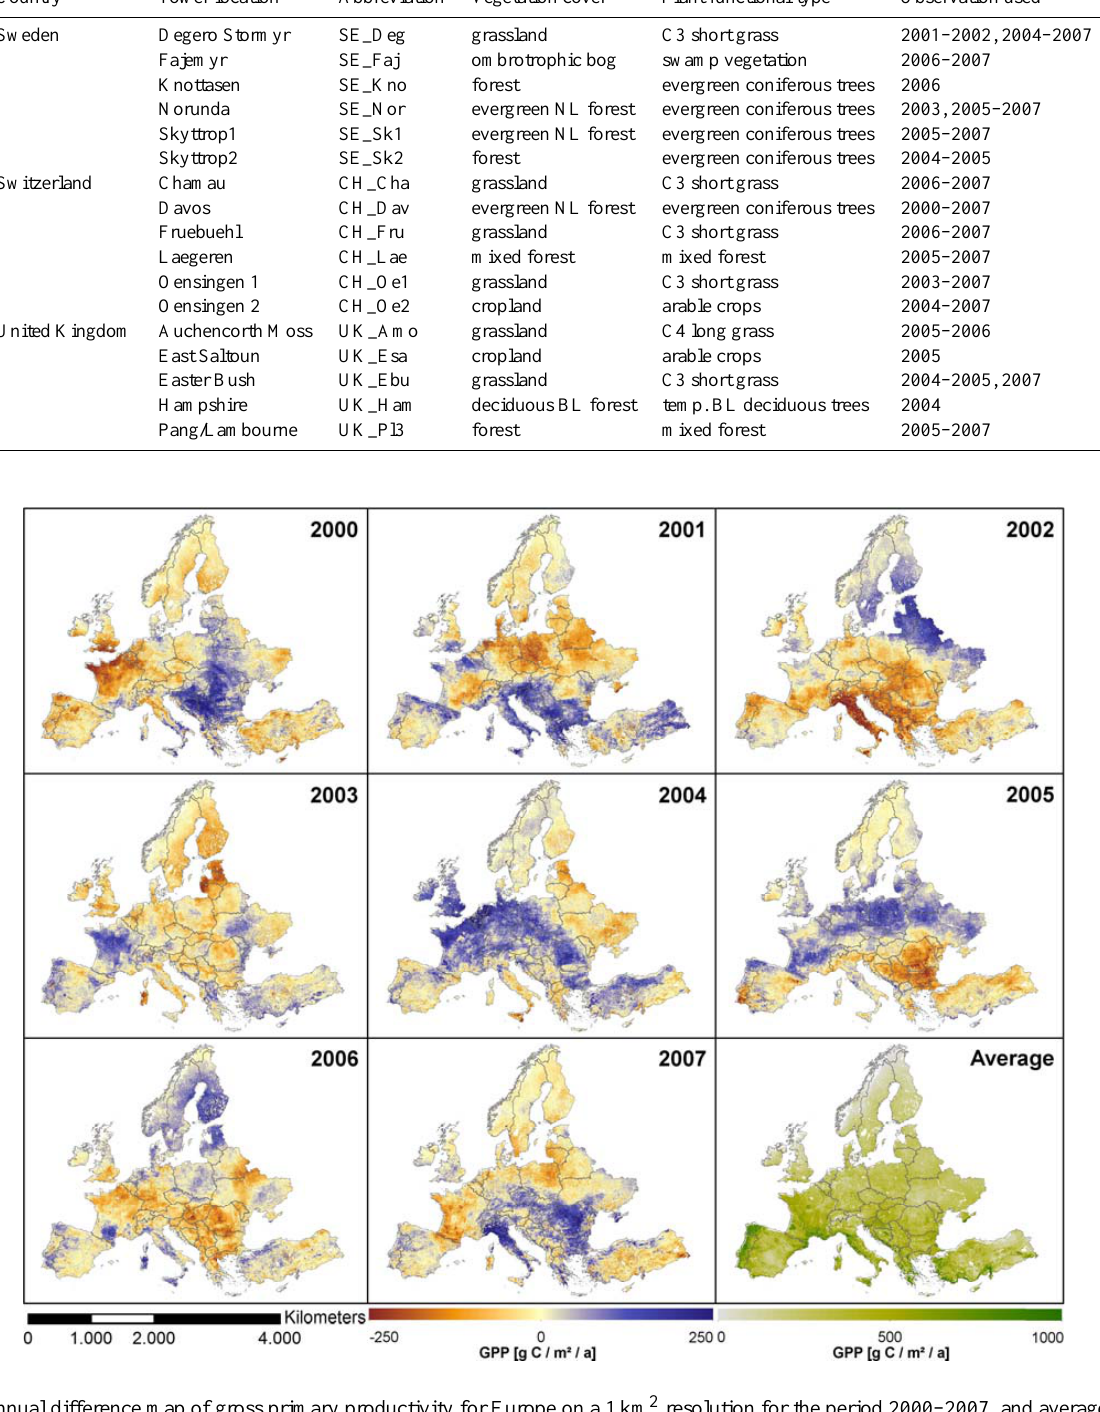
Figure 2: Annual difference map of Gross Primary Productivity for Europe on a 1 km² resolution for the period 2000 – 2007, and averaged GPP. Negative deviations are represented in red; positive deviations in blue. The averaged GPP is represented in grey (low values) to green (high values). White areas symbolize urban areas, water bodies and no data.